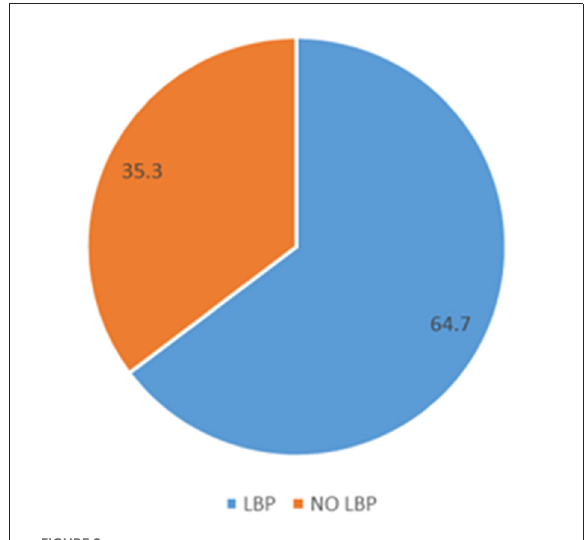
FIGURE2 Pie chart representing the prevalence.